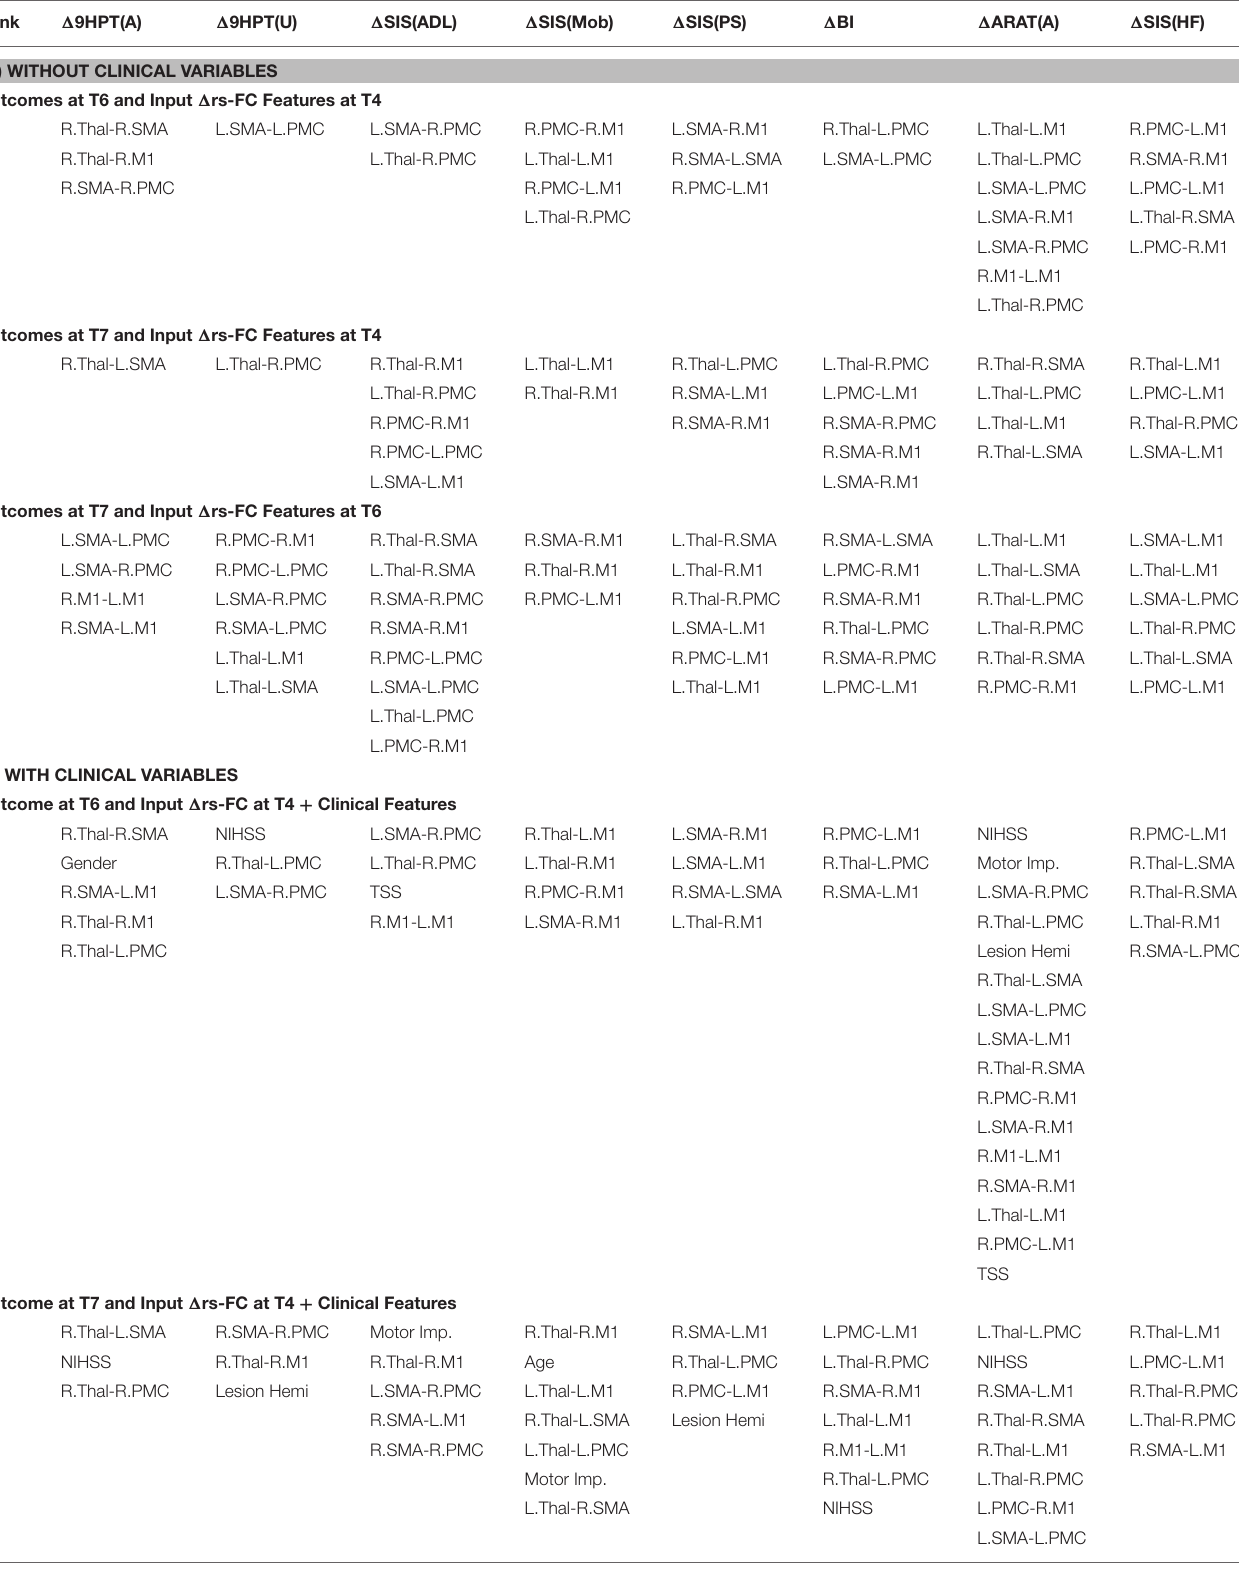
TABLE 7 | List of 1 rs-FC correlates of 1 behavior between all pairs of time-points identified by using linear-kernel SVR are presented below. Rank (A) WITHOUT CLINICAL VARIABLES Outcomes at T6 and Input 1 rs-FC Features at T4